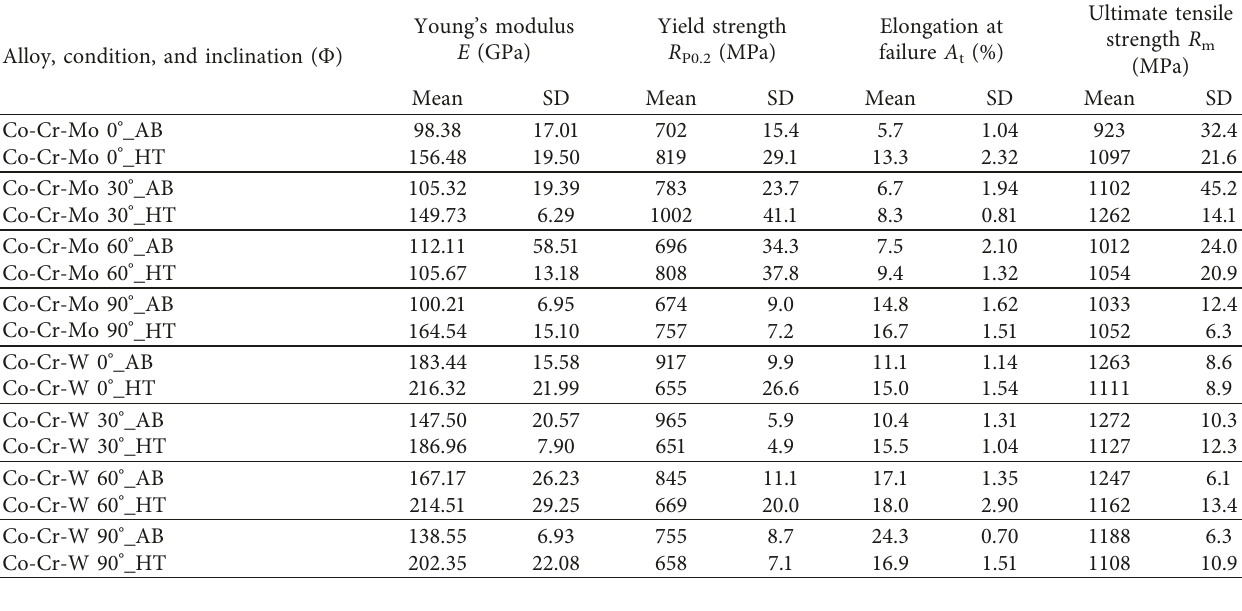
Table 1: Tensile properties of Co-Cr-Mo and Co-Cr-W.